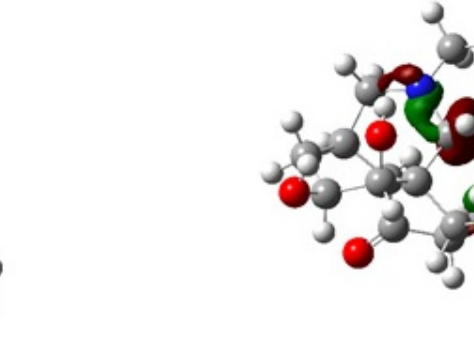
Figure 6. HOMO-LUMO of Compound 1 calculated at B3LYP/6-31þG (p).